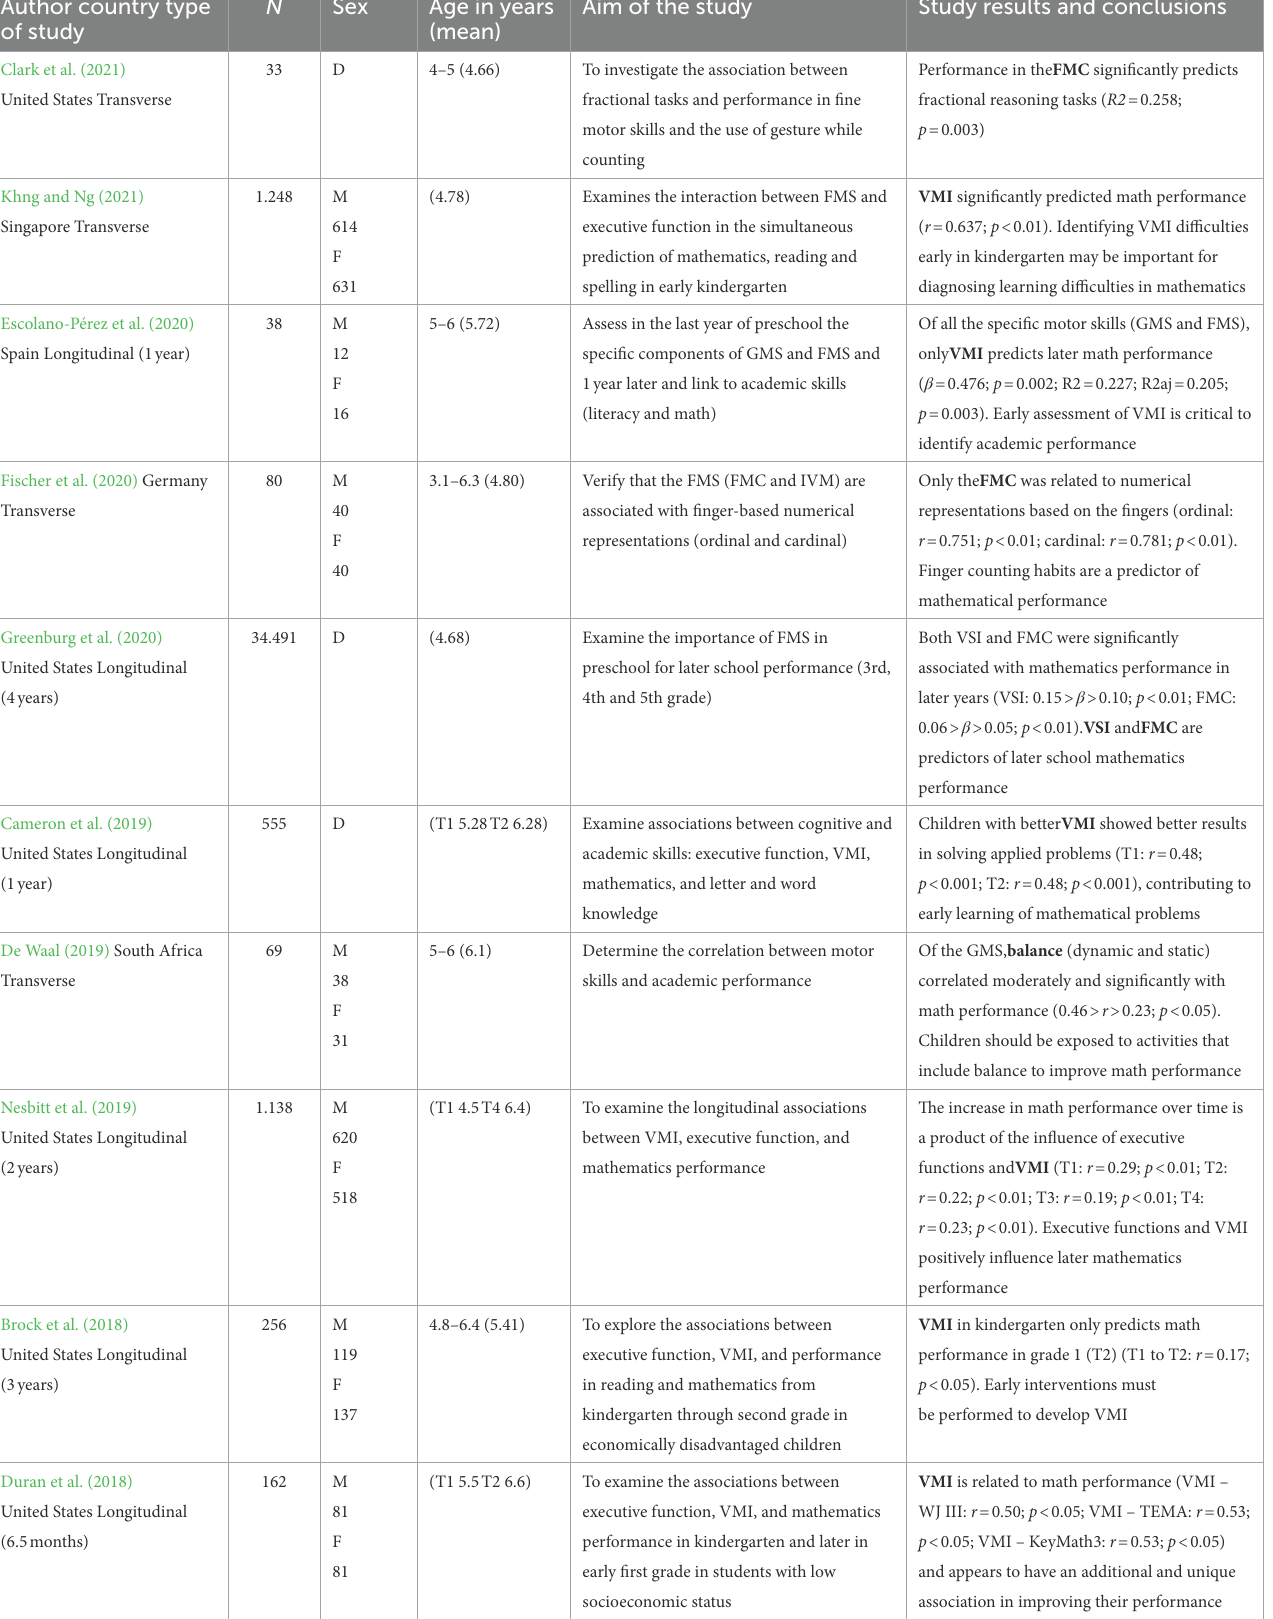
TABLE 2 Characteristics of studies that investigated the relationship between motor skills and mathematic performance in children who attended the preschool education with typical development. Author country type of study